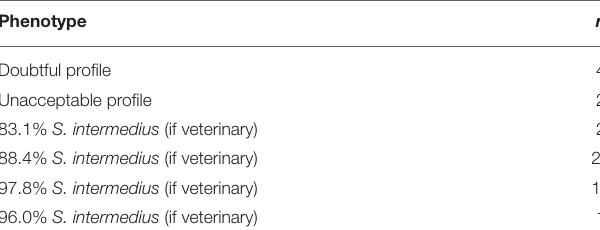
TABLE 1 | Phenotyping of isolated staphylococci, according to API-Staph ® . Phenotype n